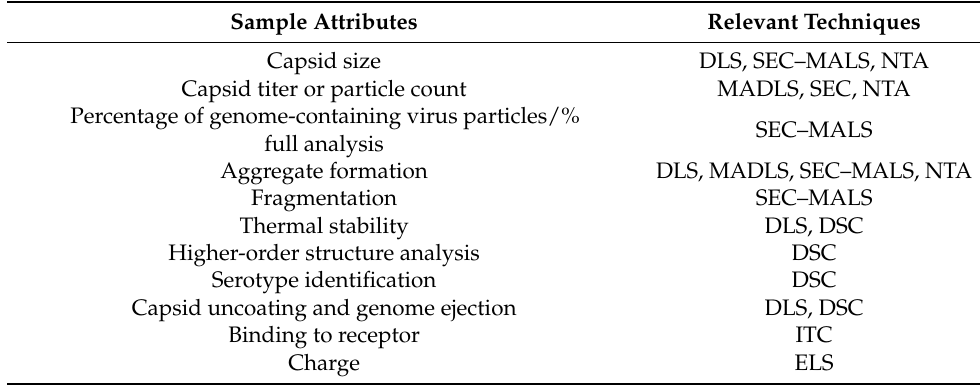
Table 1. Summary of the critical quality attributes (CQAs) important in viral vector research and the techniques that can provide this information. Sample